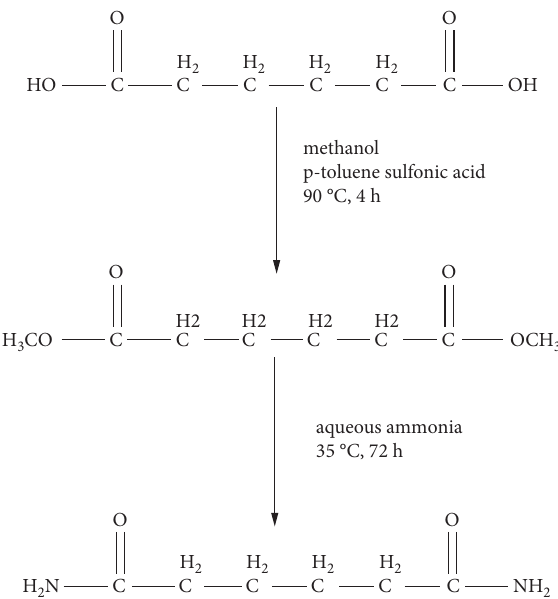
Figure 4: Synthetic route of adipamide